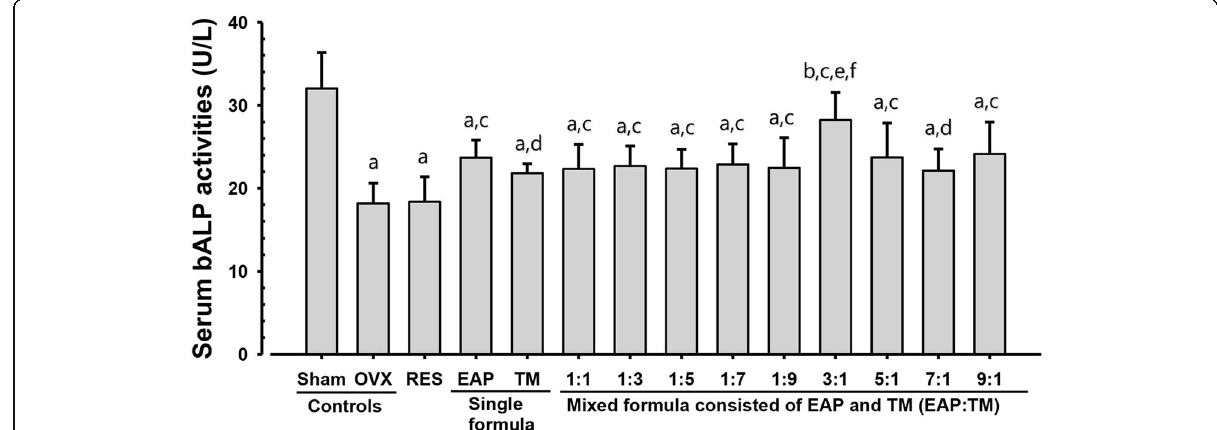
Fig. 3 Serum bALP levels in sham-operated and OVX mice. OVX: Bilateral ovariectomy; RES: Risedronate sodium; EAP: Exopolymers purified from A. pullulans SM2001; TM: T. morbifera leaf extracts; (EAP:TM): Mixed formula consisted of EAP and TM ( g / g ). Values are expressed mean ± S.D. of eight mice. OVX = Bilateral ovariectomy; RES = Risedronate sodium; RES was orally administered at a dose level of 2.5 mg/kg. All single and mixed formula consisted of EAP and TM were administered at a dose level of totalized 200 mg/kg by gastric gavage. a p < 0.01 and b p < 0.05 as compared with sham control by LSD test. c p < 0.01 and d p < 0.05 as compared with OVX control by LSD test. e p < 0.01 as compared with EAP single formula treated mice by LSD test. f p < 0.01 as compared with TM single formula treated mice by LSD